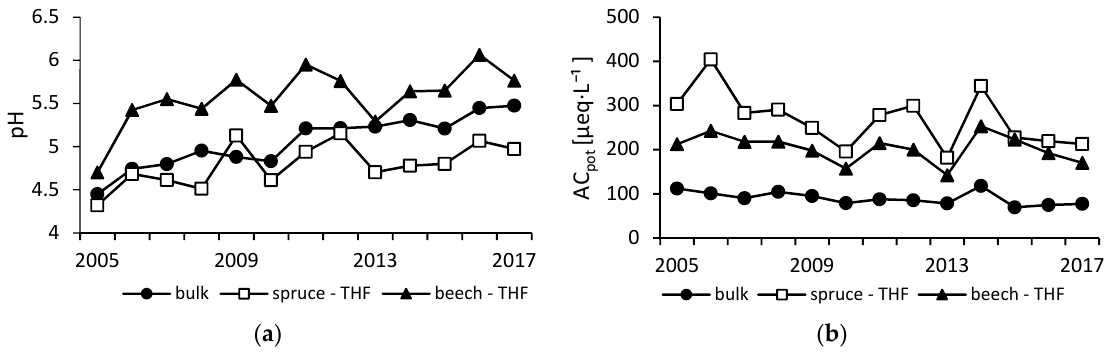
Figure 1. pH ( a ) and mean annual concentrations of potential acidity AC pot (sum of SO 42 − , NO 3 − , NH 4+ , and non-salt Cl − ) ( b ) in bulk, throughfall (THF) spruce, and THF beech precipitation.